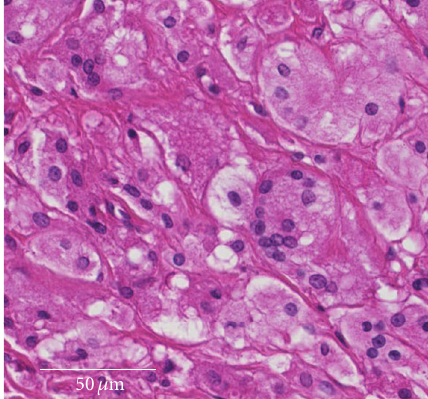
Figure 5: Histologic findings of the scar tissue. There are numerous foamy macrophages but no evidence of acute inflammation. Scale bar: 50 𝜇